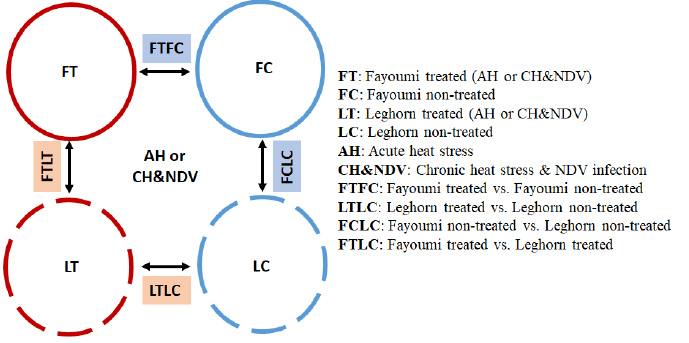
Figure 1. The comparison groups with acute heat stress and chronic heat stress & NDV infection for RNA-seq analysis.